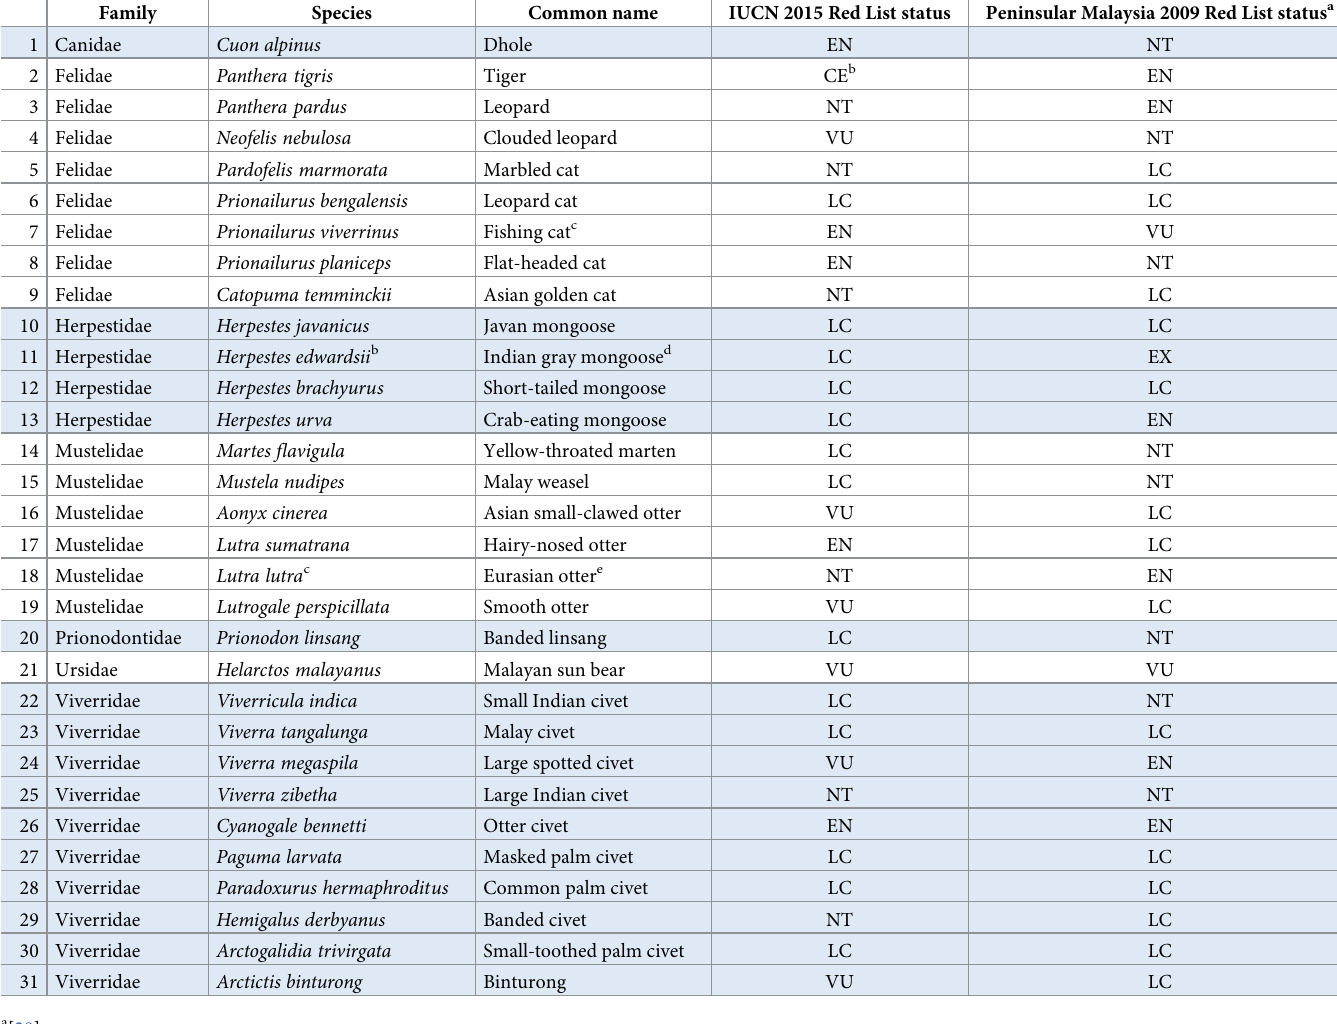
Table 1. Carnivores of Malaysia with 2015 IUCN conservation status, and Peninsular Malaysia conservation status in 2007 and 2009 based on percent change in area of occupancy and expert opinion [28]. Although 31 species are listed, three species may not be indigenous or extant. The highest threat status, based on IUCN Red List criteria A–E [29] is reported for each species. EX = extinct, CE = critically endangered, EN = endangered, VU = vulnerable, NT = near threatened, LC = least